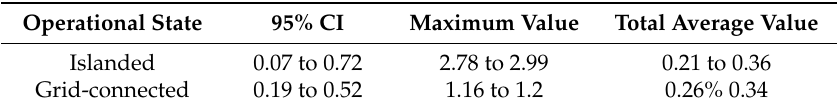
Table 6 . 95% confidence interval, the maximum 10 min value and total average value for all three phases in islanded and grid-connected operation.